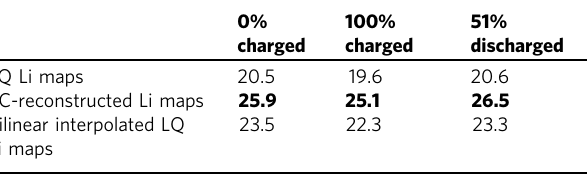
A higher PSNR indicates that the reconstructed Li map is more similar to the standard image. Because we could not obtain noise-free Li-ion maps in the practical experiments, we used the HQ Li maps as the standard images. Bold values show the highest PSNR at each